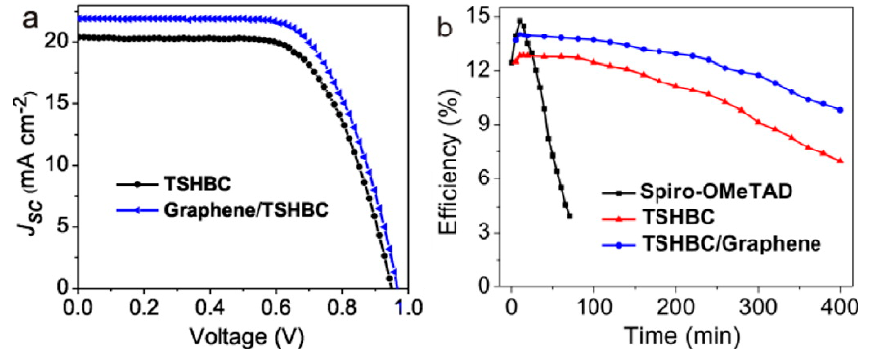
Figure 9. ( a ) Best I − V curves of TSHBC (perthiolated trisulfur-annulated hexa-peri-hexabenzocoronene) and G/TSHBC-based cells and ( b ) Device stability test with AM1.5G under 45% humidity [69].